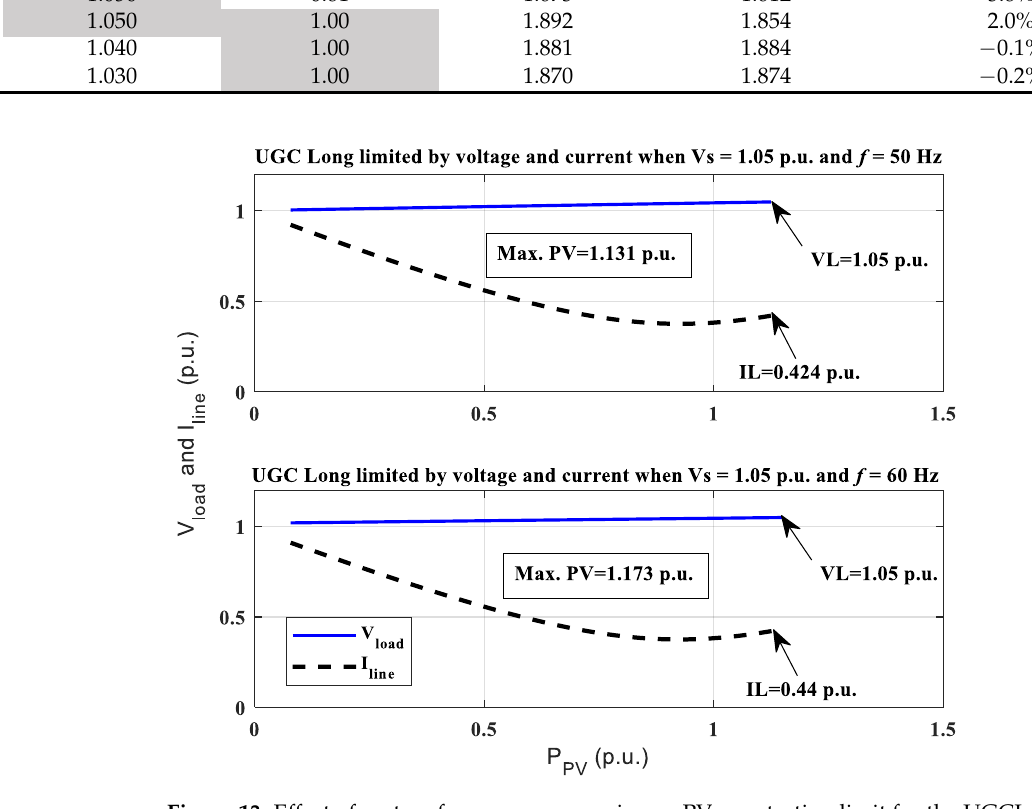
Figure 13. Effect of system frequency on maximum PV penetration limit for the UGCL (Substation voltage 𝑉 𝑆 = 1.05 p.u. ).